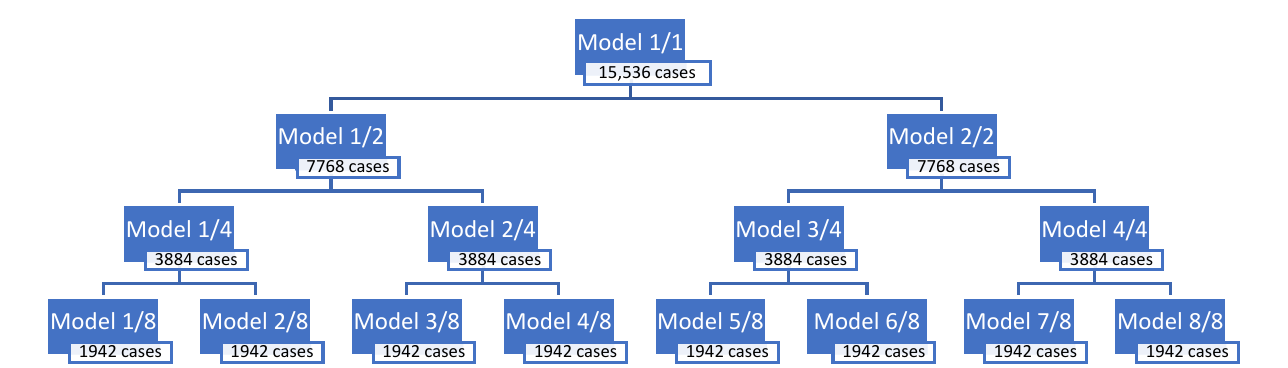
Figure 3. The scheme of the division into sub-ranges for the Zabrze station.